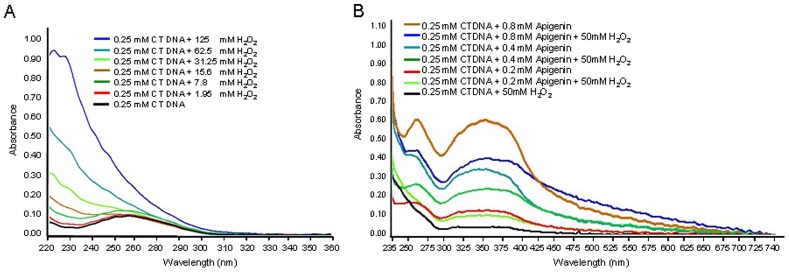
UV-Vis spectra of H2O2 and its quenching by apigenin.(A) UV-Vis spectra of calf thymus (CT) DNA incubated with varying concentration of H2O2 ranging from 1.95 mM to 125 mM. (B) Quenching of UV-Vis spectra by apigenin after H2O2 treatment. CT-DNA was incubated with varying concentration of apigenin ranging from 0.2 mM to 0.8 mM followed by H2O2 treatment. The experiment was repeated three times with similar results. Details are described in materials and methods section.